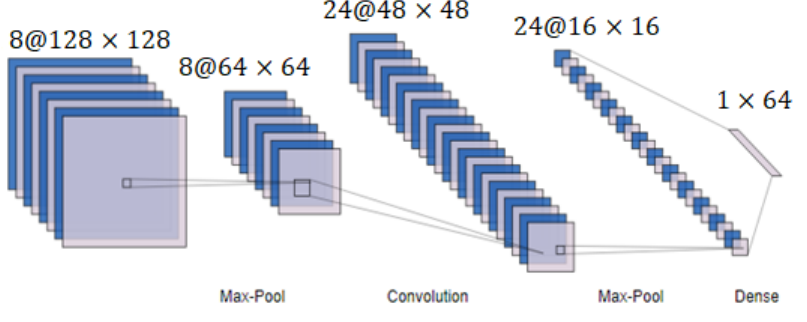
Figure 2. Architecture of a CNN.